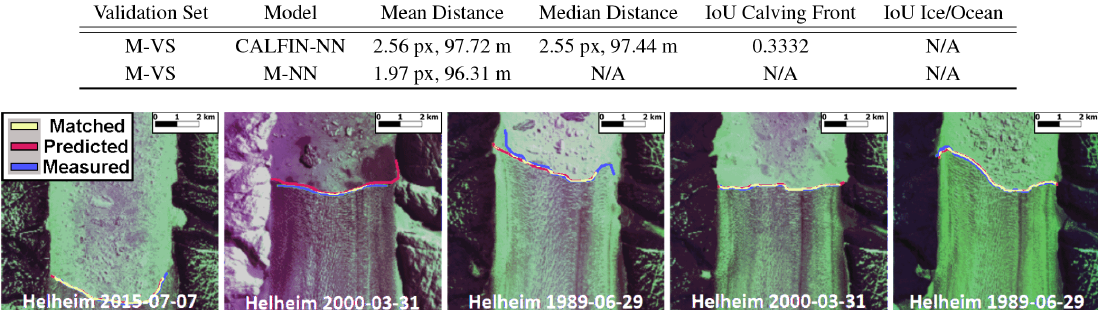
Figure 10. M-VS validation output results. Note that CALFIN-NN has never trained on Helheim but can still predict the front under different conditions and preprocessing methods. See Fig. S9 for full outputs.